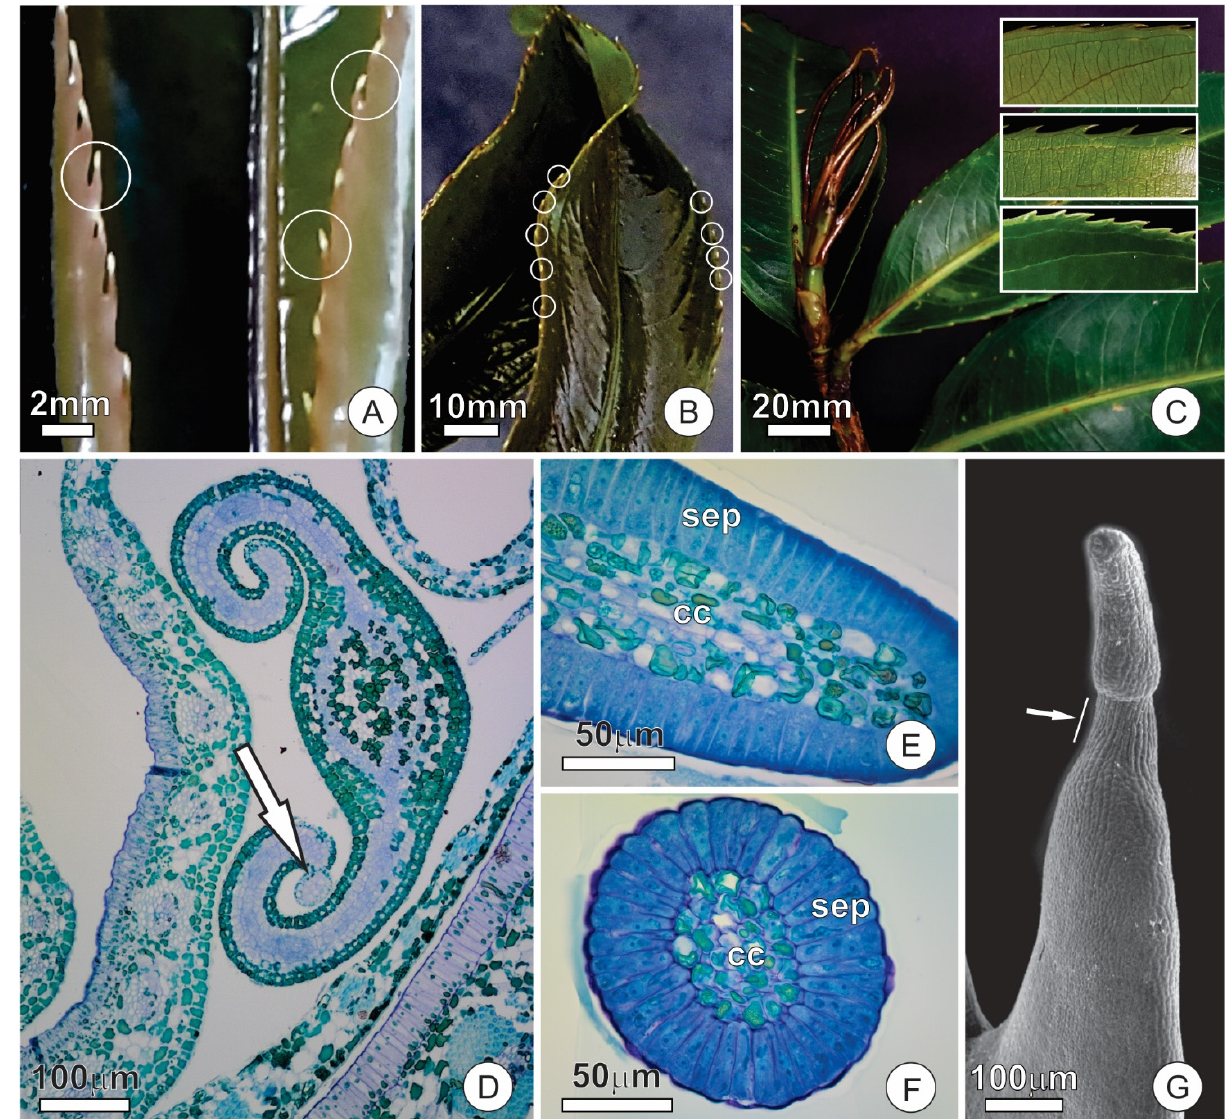
Figure 4. Distribution and structure of leaf colleters of O. castaneifolia leaves: ( A – B ) Young leaves, at the final stage of expansion, with hyaline colleters at the apex of the marginal teeth (circles). ( C ) Vegetative bud showing young leaves above mature leaves (from last sprouting event). Young leaves are shinny due to spread of colleter secretion; mature leaves present prominent marginal teeth. The inserts show the sequence of leaf maturation; notice the marginal teeth of the unexpanded young leaf (on top), followed by colleter abscission, intense sclerification and, finally, the fully-developed marginal spines (bottom). ( D ) Cross-section of a young leaf with involute ptyxis. Note the colleter at the leaf margin (arrow). ( E ) Longitudinal section of a colleter showing the secretory epidermis with columnar palisade cells and a central axis. ( F ) Cross-section of a colleter showing secretory epidermis surrounding the central axis. ( G ) Scanning electron micrograph of a marginal tooth in a young leaf. Note that the conical-shaped colleter at the apex is connected through a peduncle region (arrow). cc = central axis; sep = secretory epidermis.